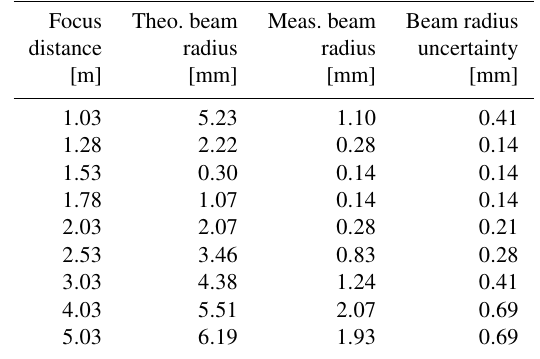
Table 3. Theoretical and measured beam widths together with esti- mated uncertainties for the different focus distances used. Focus Theo. beam Meas. beam Beam